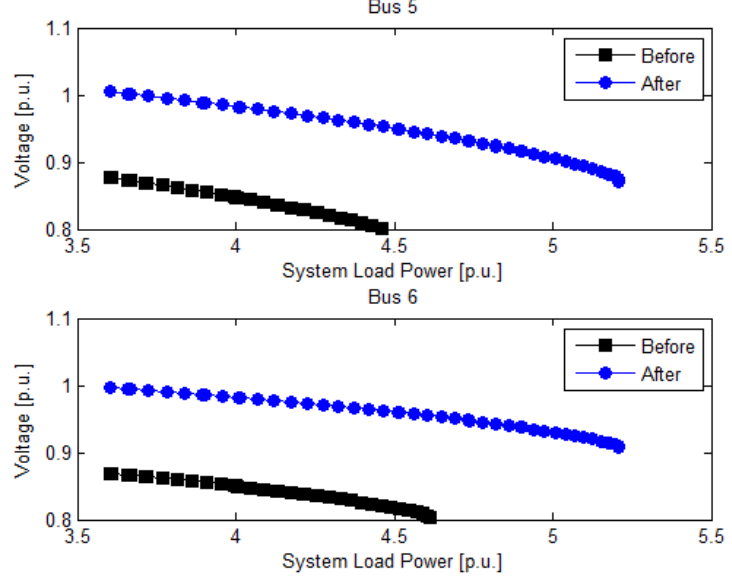
Figure 7. Simulation result of Case 3 for IEEE